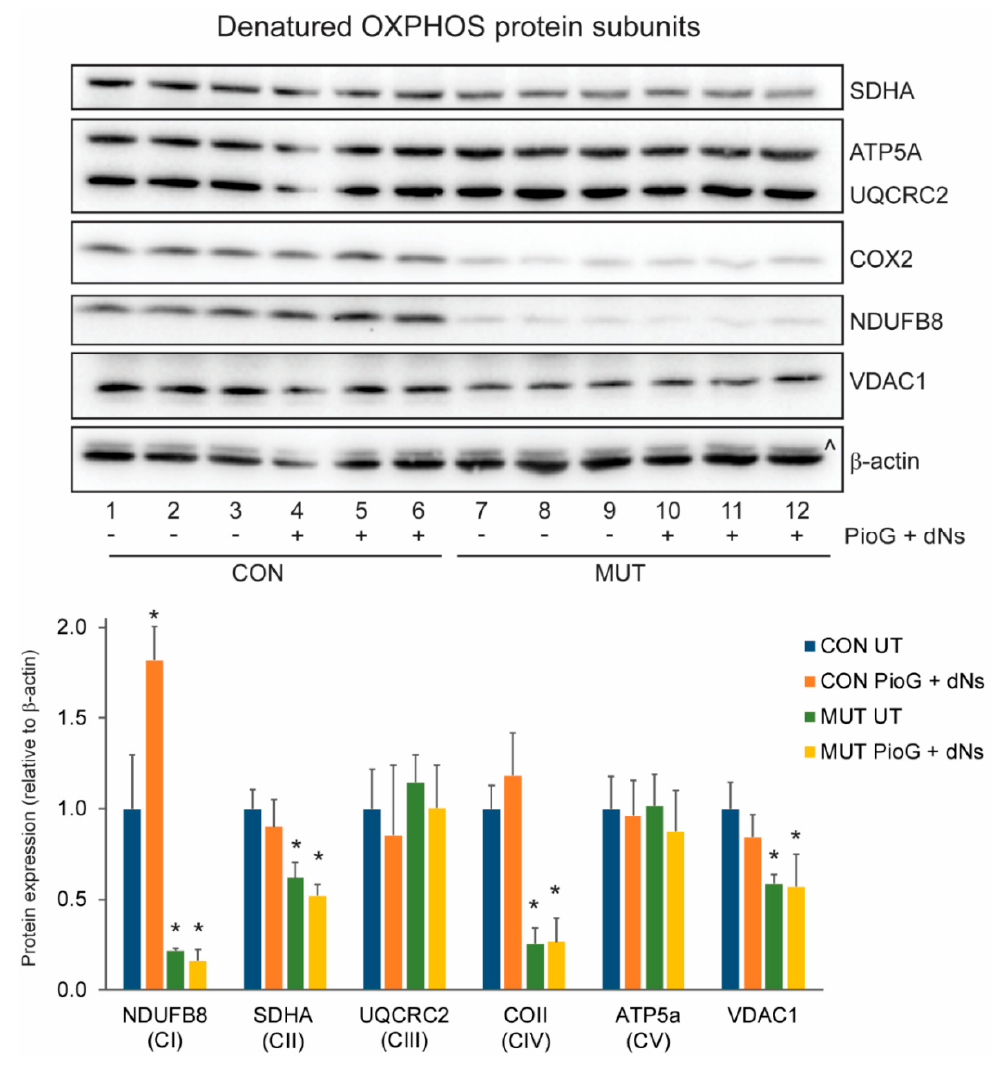
Figure 3. Effect of seven days PioG + dNs combination treatment on individual oxidative phosphorylation (OXPHOS) subunit steady-state levels in control (CON) cybrids and m.3243A>G (MUT) cybrids. Levels of NDUFB8, SDHA, COII, and voltage-dependent anion-selective channel protein 1 (VDAC1) were lower in untreated MUT cybrids compared to untreated CON cybrids. PioG + dNs treatment resulted in the increase in NDUFB8 in CON cybrids, but did not alter levels of any other proteins in either CON or MUT cybrids. UT = untreated; ˆ, UQCRC2 detected from previous immunodecoration. Values shown are mean ± s.d. * p < 0.05 relative to untreated CON values (Student’s t